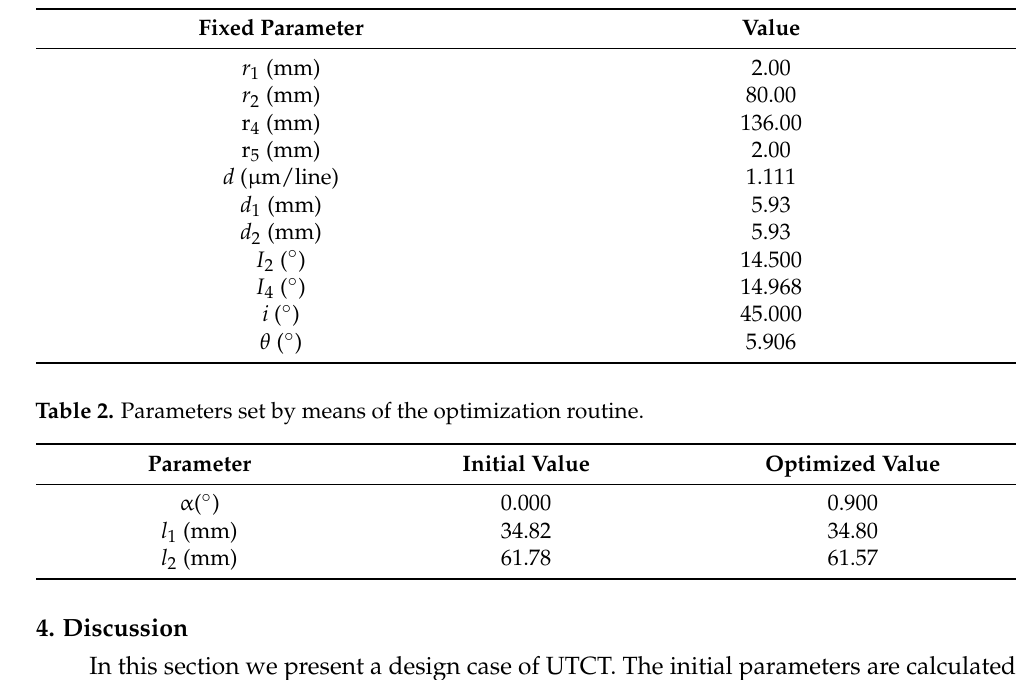
Table 1. Parameters set by means of the Coddington s Equations (fixed parameters).